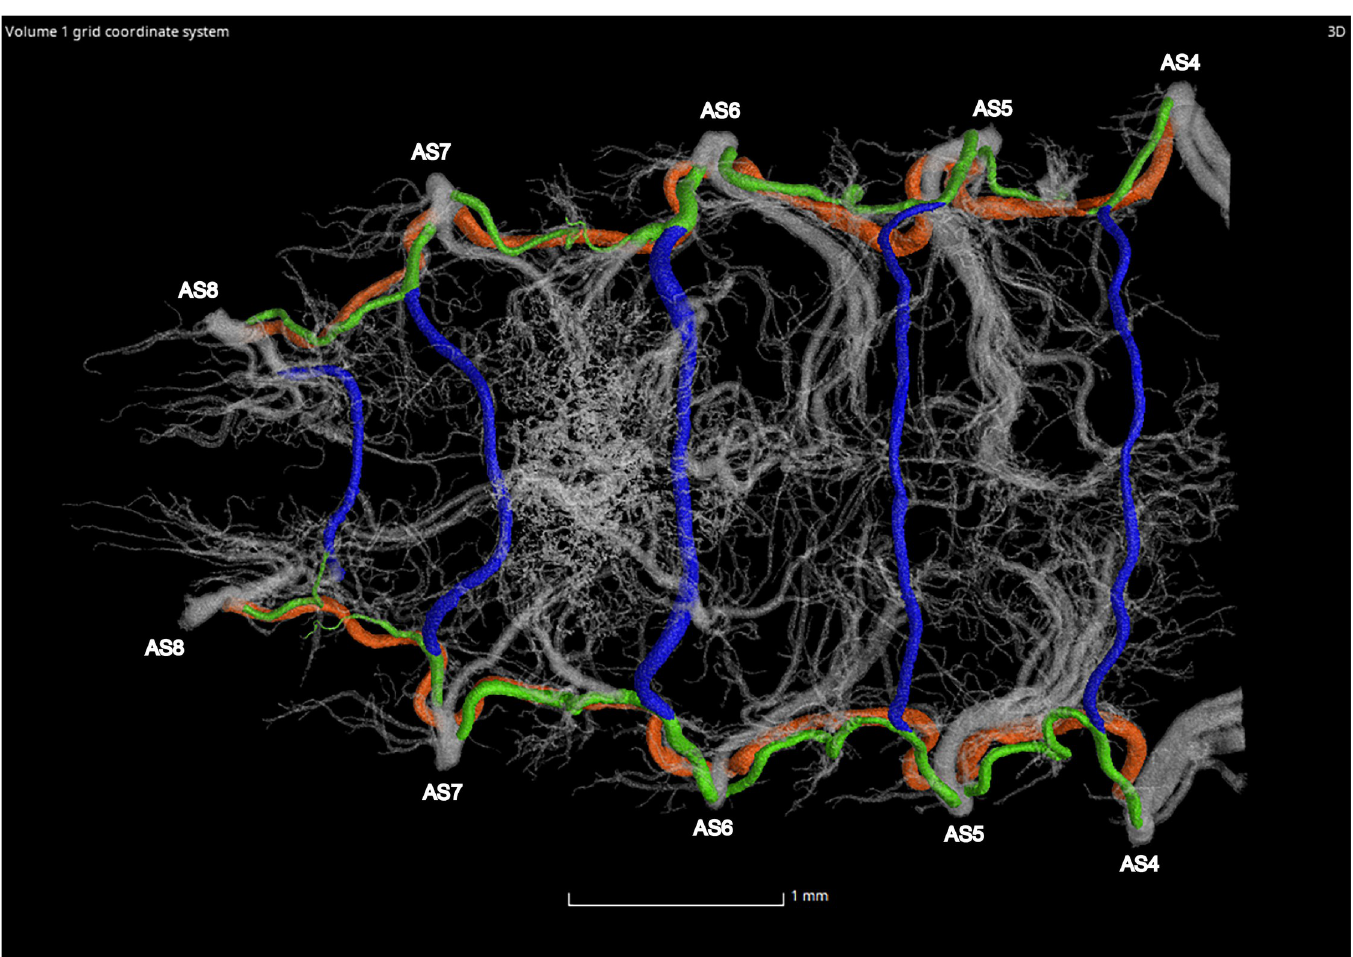
Fig 26. Ventral view of the adult female Photinus pyralis tracheal. Ventral commissures (VC; blue), dorsal longitudinal trunks (DLT; orange), and ventral longitudinal trunks (VLT; green) highlighted for volumetric analysis.